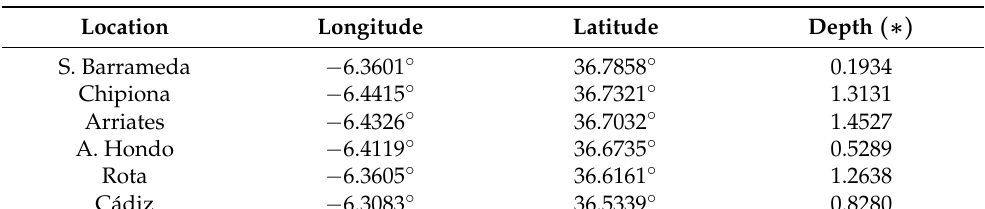
Table 2. Geographical coordinates of the locations used as forecasting points. (*) Depth values (in meters) refer to the numerical interpolations.